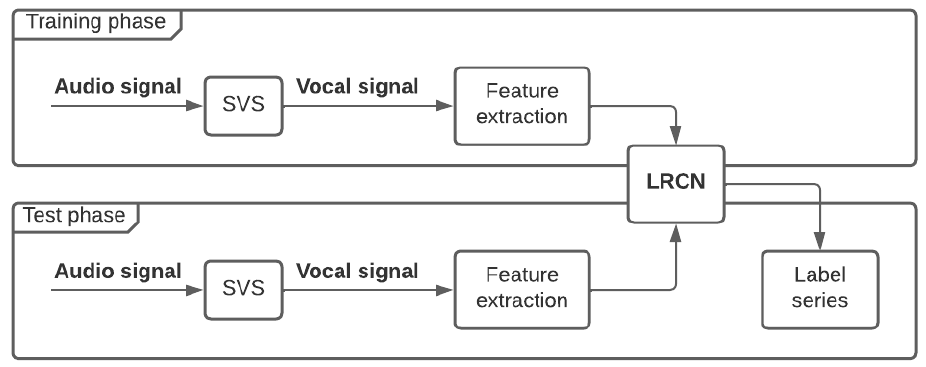
Figure 1. Overview of the proposed SVD system, including preprocessing, feature extraction, and LRCN feeding in the both training and test